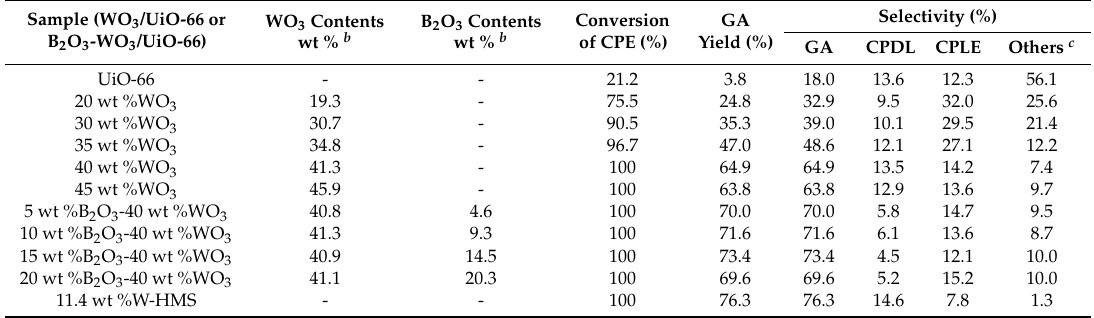
Table 2. Catalytic performance in the selective oxidation of cyclopentene (CPE) over various samples a